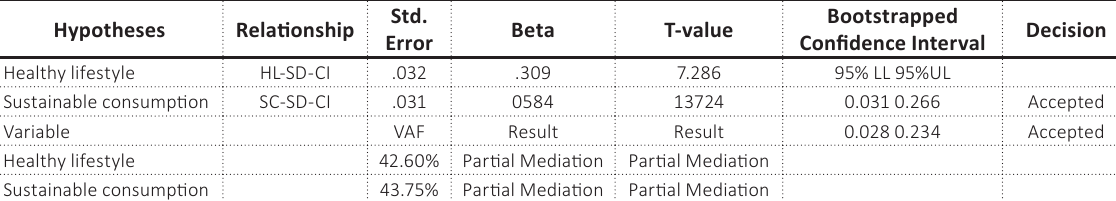
Table 16. Path analysis results using Smart PLS3